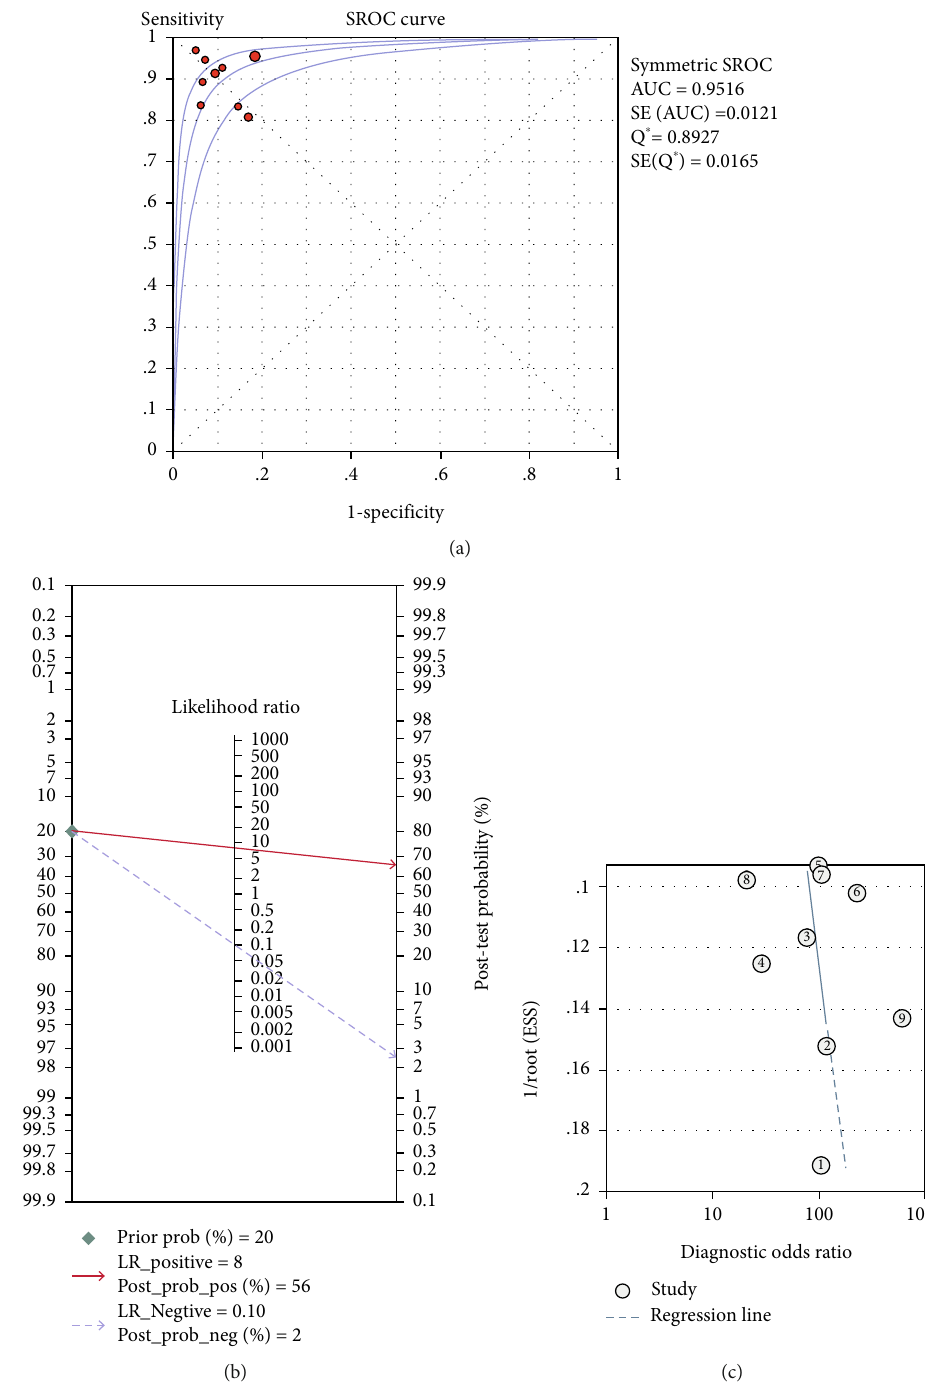
Figure 6: The SROC curve, publication bias, and Fagan Nomogram for MK in detecting benign and malignant breast lesions. SROC: summary receiver operating characteristic; MK: mean